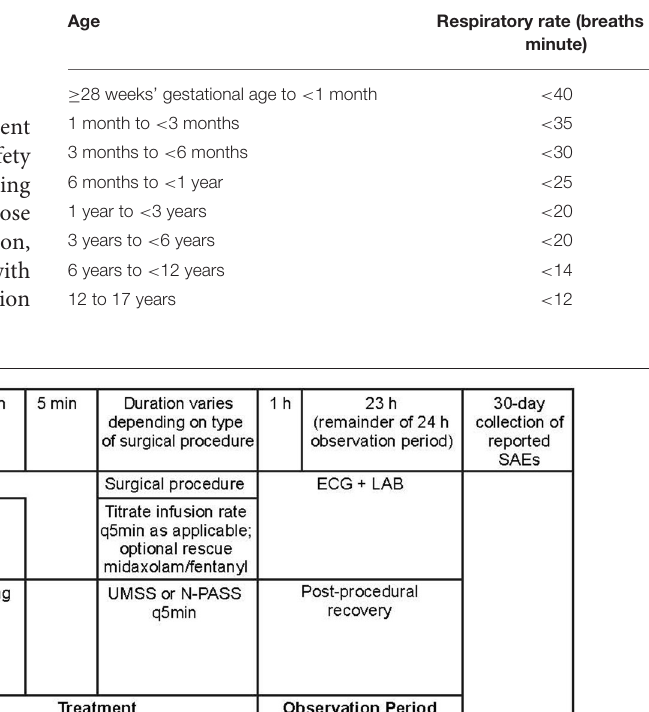
TABLE 1 | Absolute thresholds for respiratory rate defining AE of respiratory depression.